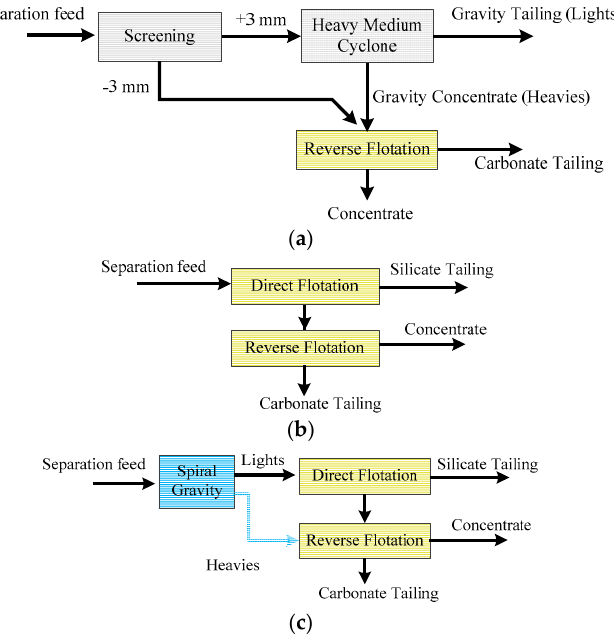
Figure 3. ( a ) Diagram of the actual process (2014); ( b ) the conventional process and ( c ) the new gravity and flotation combined process.